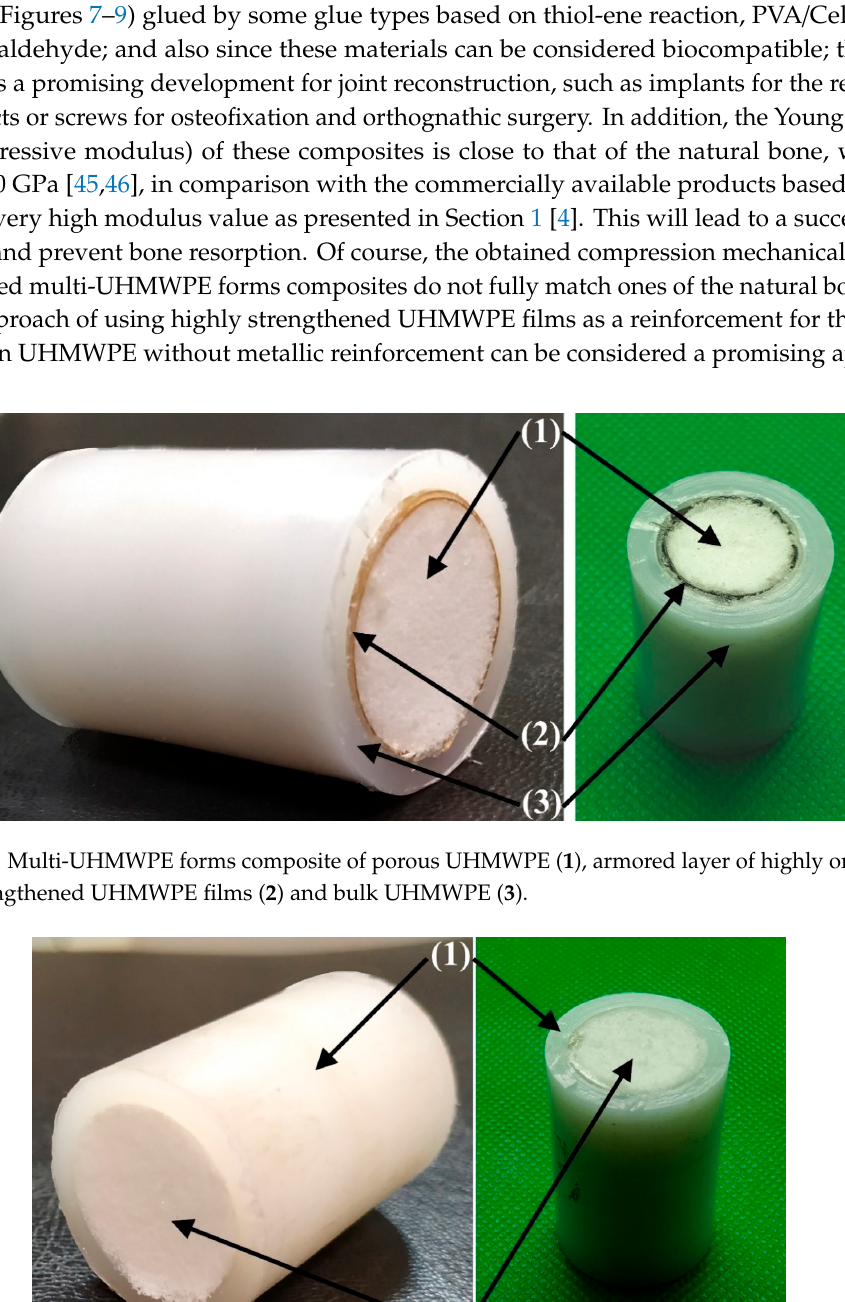
Figure 9. Cylindrical multi- UHMWPE forms samples, made of porous UHMWPE as trabecular layer and armored layer (cortical layer) that consists of bulk and films of UHMWPE. ( a ) The sample appearance in the end of the mechanical test; ( b ) dissected sample that shows the fixation of the glued multi- UHMWPE forms after the mechanical test. 4. Conclusions Three types of glue based on thiol-ene reaction, PVA/Cellulose and phenol formaldehyde were prepared and applied on modified UHMWPE films grafted by cellulose. T-peel tests indicated to the improvement of the mechanical properties of the modified UHMWPE films for all types of glue after being treated by cellulose grafting. The peel strength value increased for the glues based on thiol-ene reaction, PVA/Cellulose and phenol formaldehyde by 40, 29, and 41 times, respectively. The maximum peel strength value of 0.62 Kg/cm was obtained for the glue based on phenol formaldehyde.